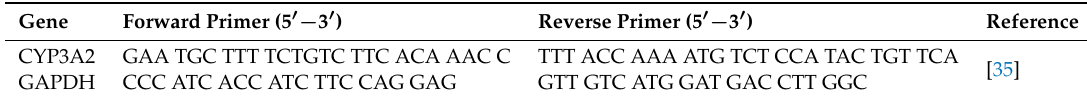
Table 2. List of Primer Sequences Used for